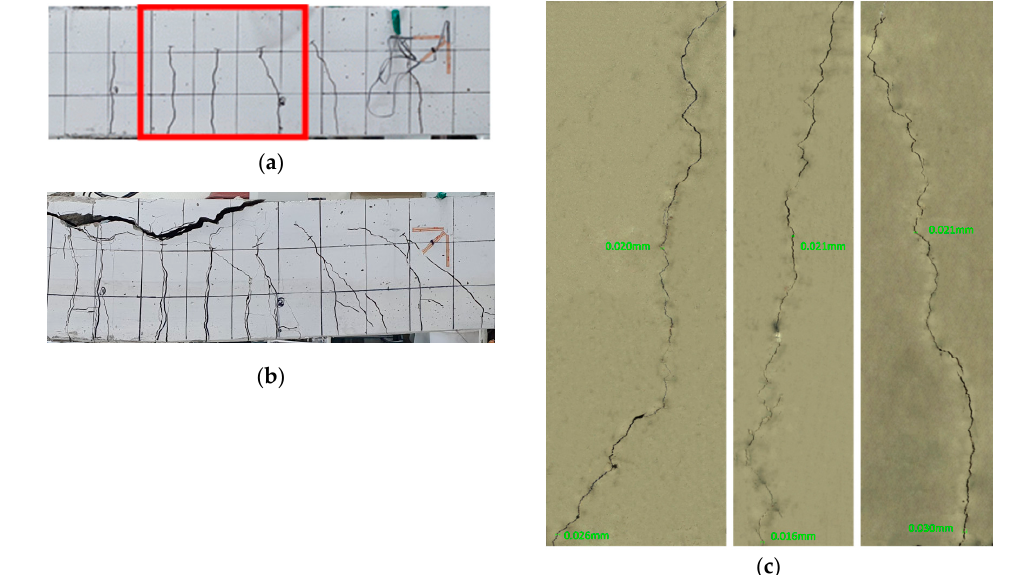
Figure 24. Crack healing of member P-RL_28 + 90D: ( a ) after pre-loading at 28 days + 90 days of additional curing; ( b ) after loading at 28 + 90 days; ( c ) enlargement of cracks after completion of test.